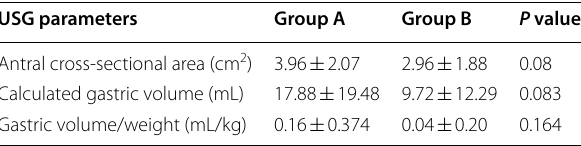
Table 2 Comparison of antral cross-sectional area (CSA), gastric volume (GV), and gastric volume per kg weight between the study